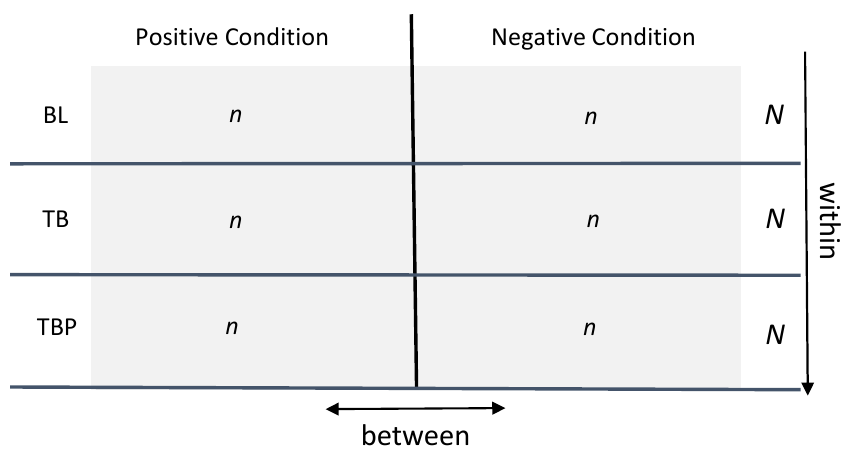
Figure 2. Study design with within and between factors.